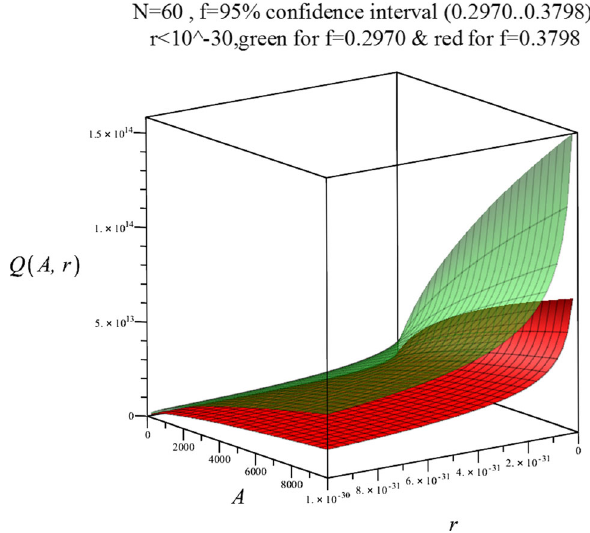
Fig. 4 In this figure, we show that the model is compatible with obser- vation (the volume between two colorful surfaces) where A is large enough even with the smaller values of dissipative parameter Q . Two free parameters A and Q have the same effects on the tensor-to-scalar ratio in this case